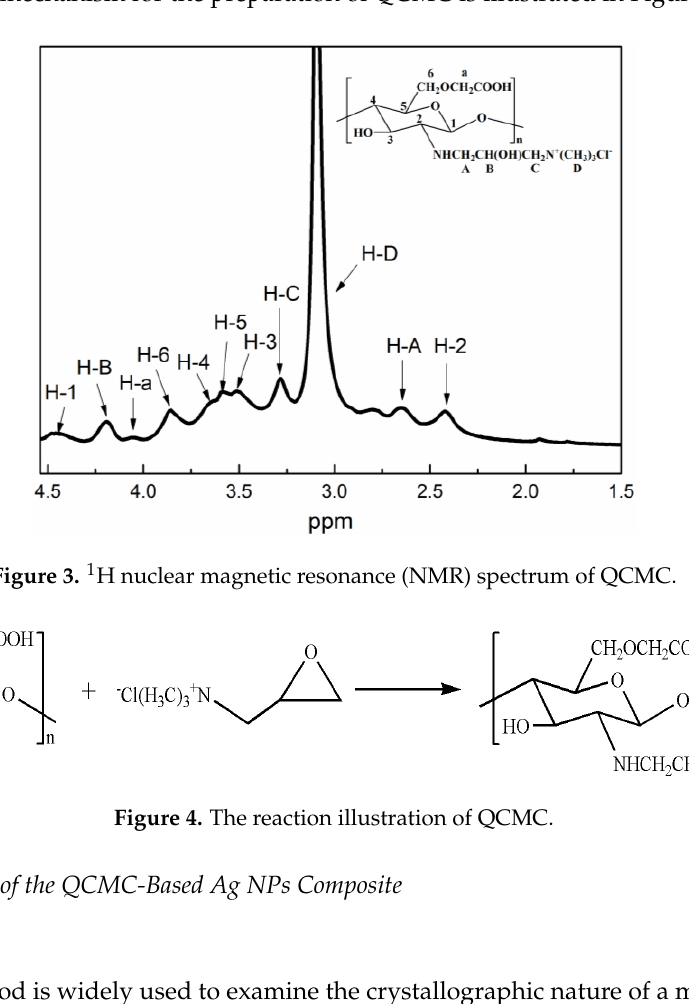
Figure 2. Fourier transform infrared (FT-IR) spectra of ( a ) carboxymethyl chitosan (CMC) and ( b ) Quaternized carboxymethyl chitosan (QCMC).